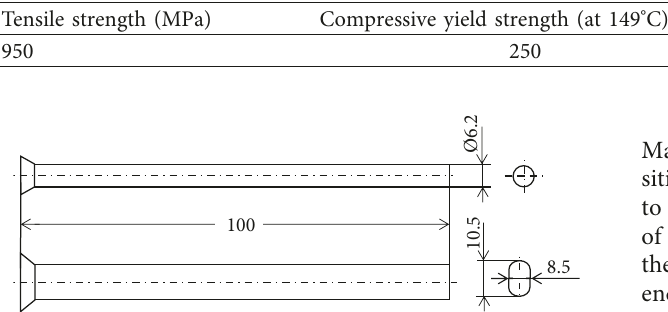
Figure 2: AISI M2 tool steel circular and slot punches (DIN